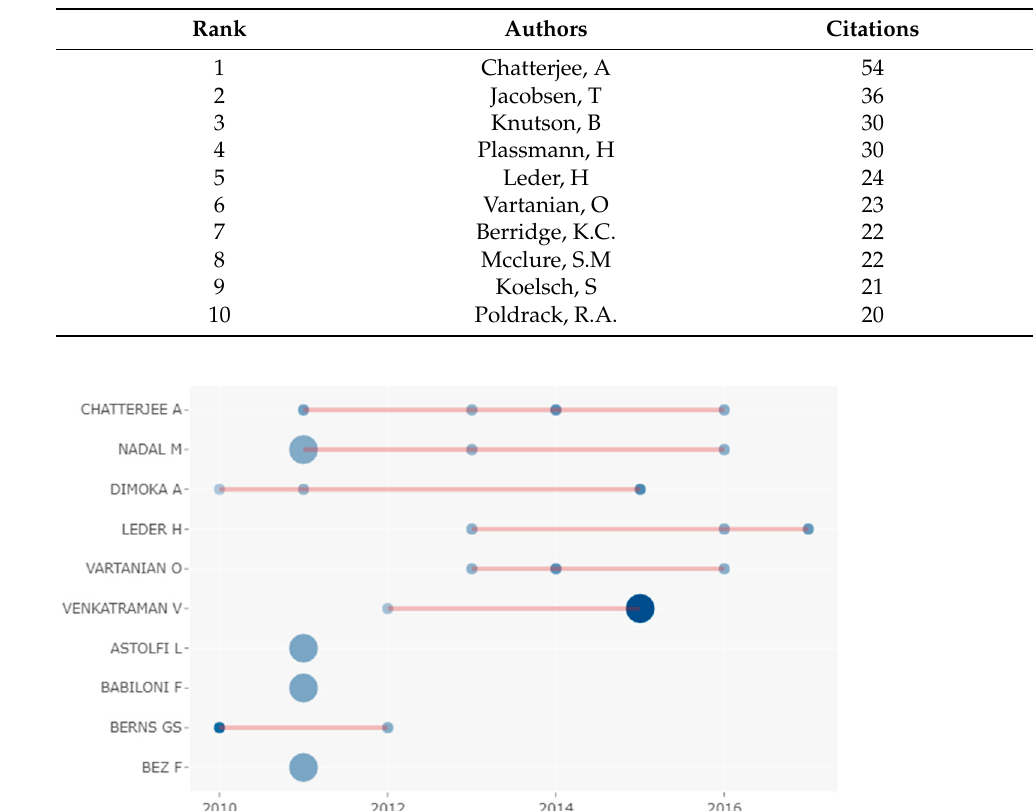
Table 9. Top 10 Most Local Cited Authors.